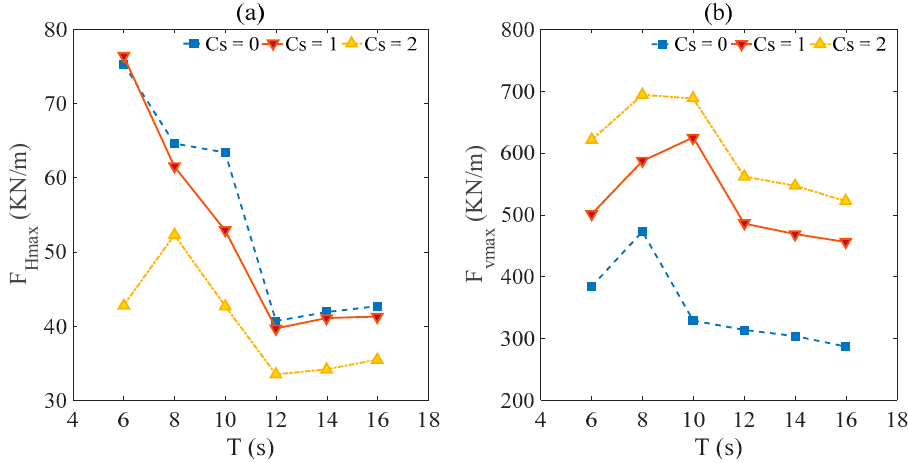
Figure12. ( a ) Maximum horizontal force ( F H max ) and ( b ) Maximum uplift force ( F v max ) Maximum wave forces versus wave period ( T ) for the case of box girder under three different submerged coefficients ( C s ).